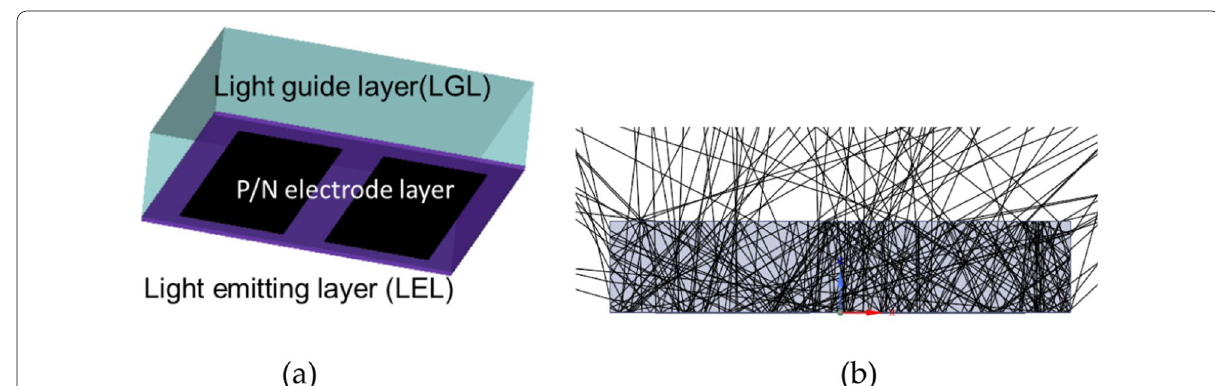
Fig. 4 Structure of the UV‑C LED; a three dimensional structure of the UV‑C LED simulation, and b light trace simulation diagram